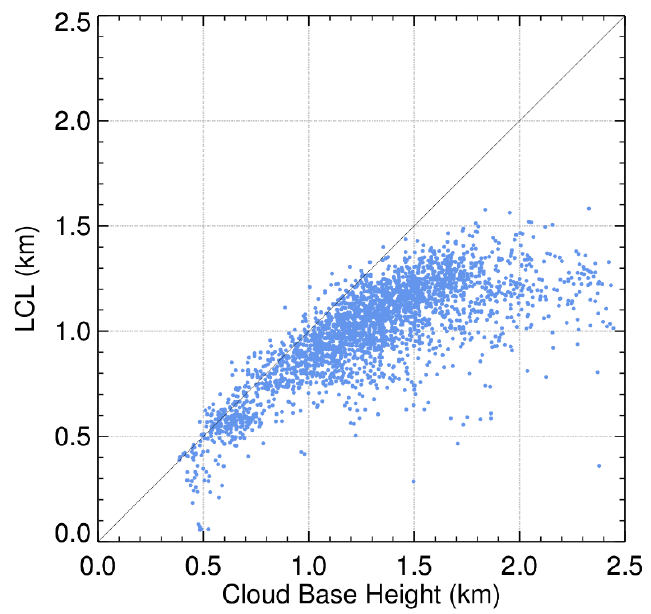
Figure 9. Scatterplot showing the relationship between the cloud base height of the lidar-observed shallow cumuli and lifting condensation level (LCL) calculated from the data of surface temperature and relative humidity several minutes (depending on the cloud base height and an assumption of 1 m s − 1 upward velocity of the air parcel [54] ) before corresponding shallow cumulus occurred. In this plot, only 2744 shallow cumulus events are included because the data of corresponding surface temperature and relative humidity are available therein.